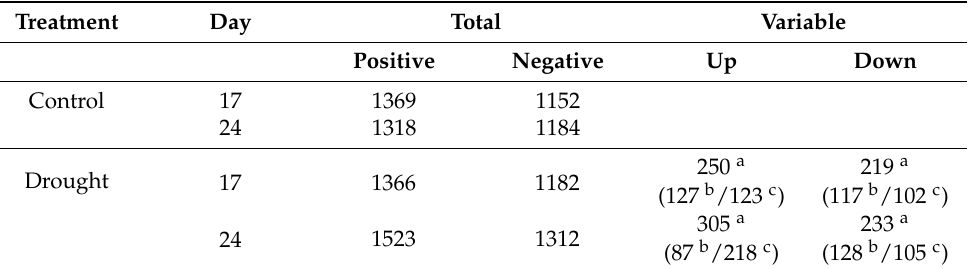
Table 1. LC-MS metabolic profile of leaf tissue extracts from irrigated and non-irrigated seedlings. The number of resolved positive and negative ion features are shown, corresponding to the mean of three biological